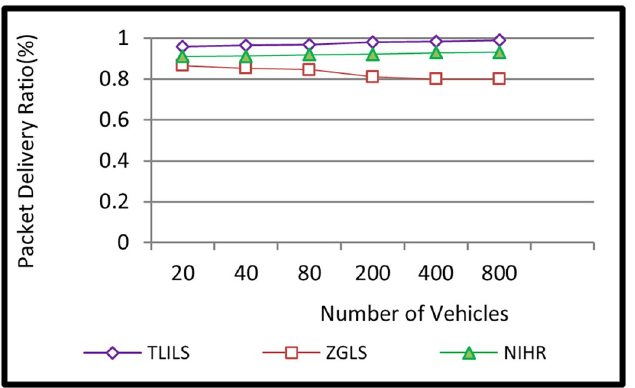
Fig 4. Information dissemination packet delivery ratio using the TLILS, ZGLS, and NIHR.